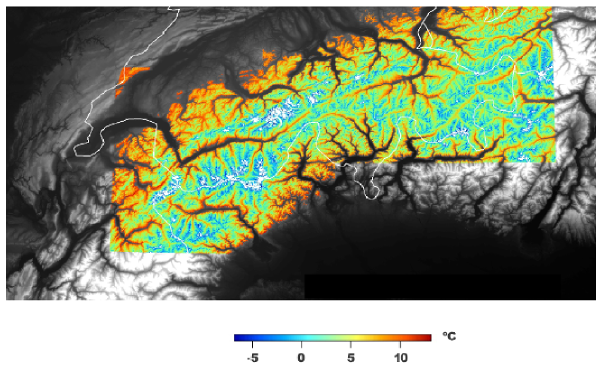
Figure 5. A visual impression of MS spatialised results: a section of a large-area simulation of MAGST with glacier mask for areas above 1000ma.s.l. (UTM zone 32 ◦ N). Switzerland’s southwestern border is overlaid for orientation.